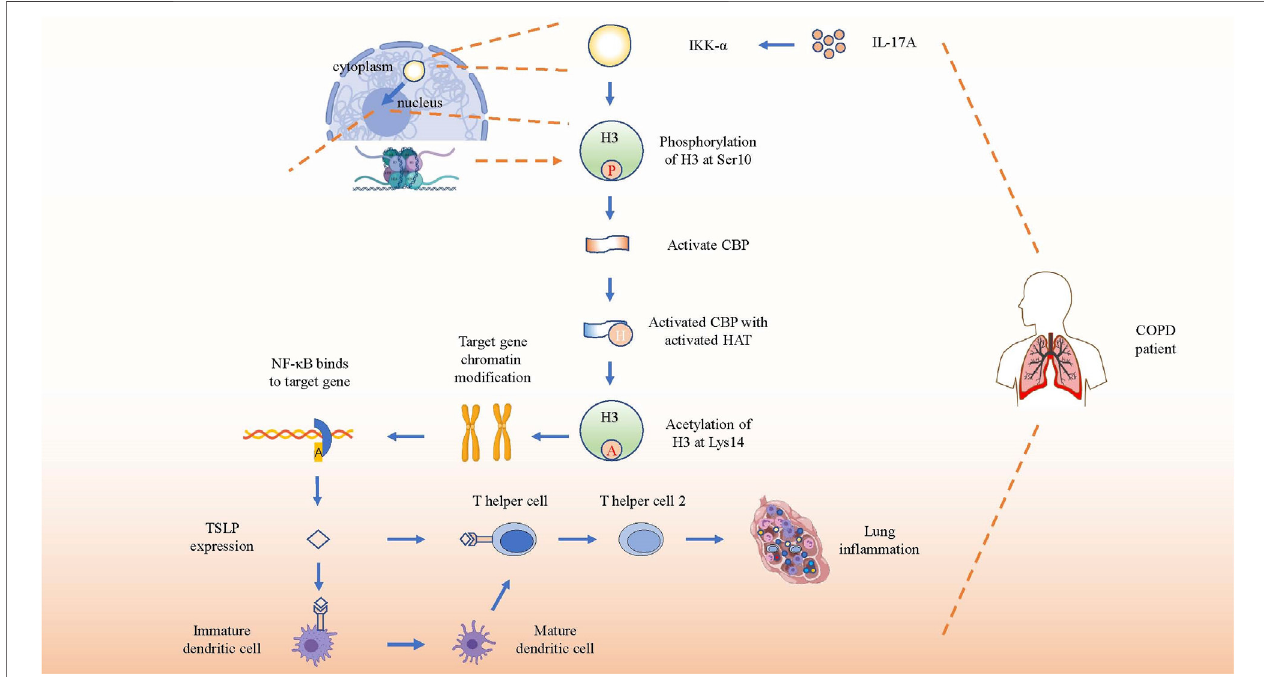
FIGURE 4 | IL-17A induces gene expression by activating IKK- α . Schematic show the pathway of in fl ammation-associated gene expression directly regulated by activatedIKK- α throughdirecttranslocationintonucleusafterreceivingthestimulationofincreasedIL-17A.AfterphosphorylationandacetylationofH3,thetargetgenes ’ chromatinwillberecombined and bindtoNF- κ BtopromoteTSLPexpression. ThenTSLPwillcombinewithitsreceptoronimmaturedendritic cellsand Thelper cellsto promote the differentiation and immune response of Th2 in COPD lung tissue.